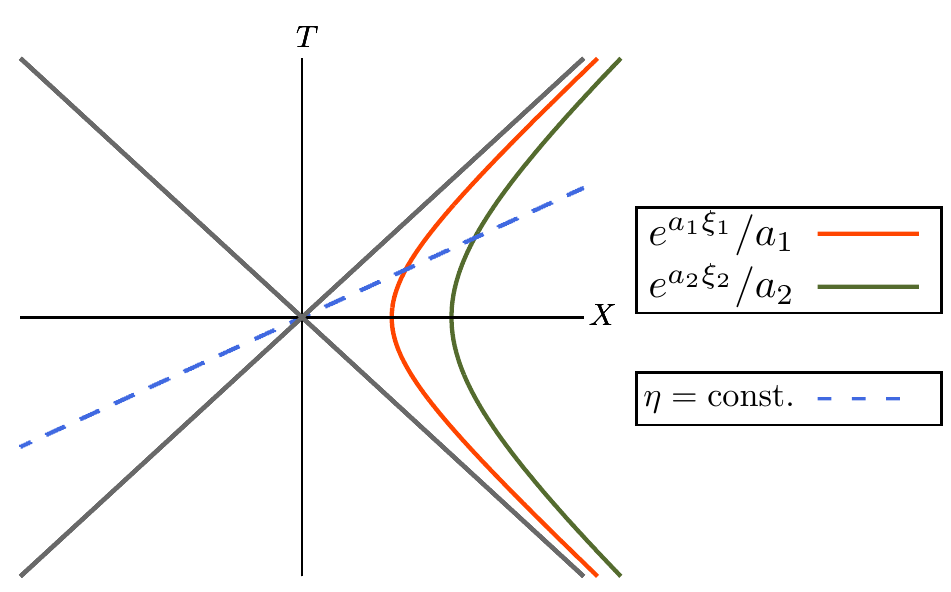
Figure 23 . Here the trajectories of two observers with two different proper accelerations are depicted in the right Rindler